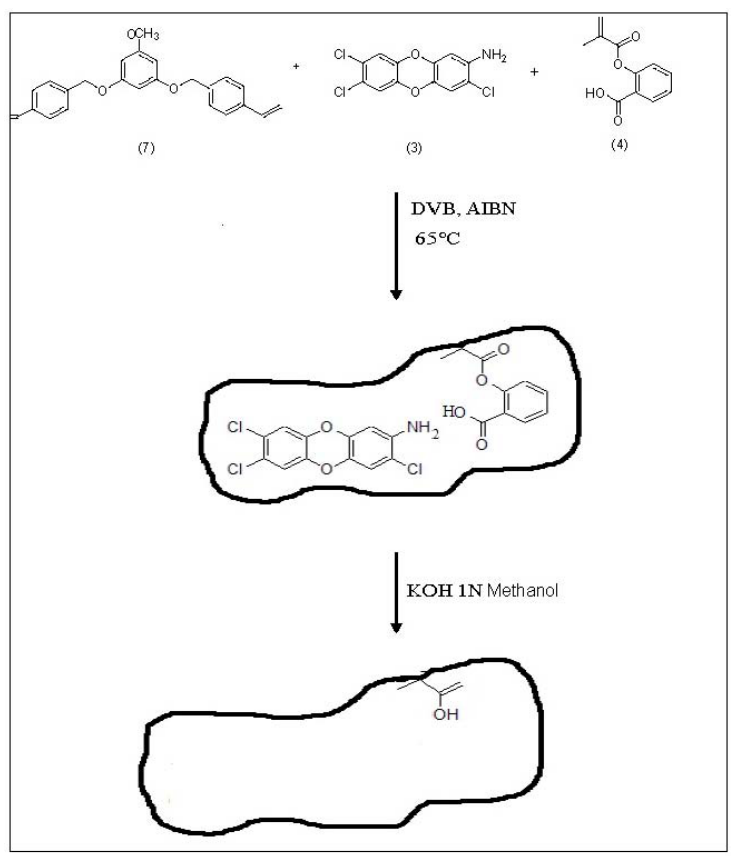
Figure 5. Synthesis of MIP2 and template removal.